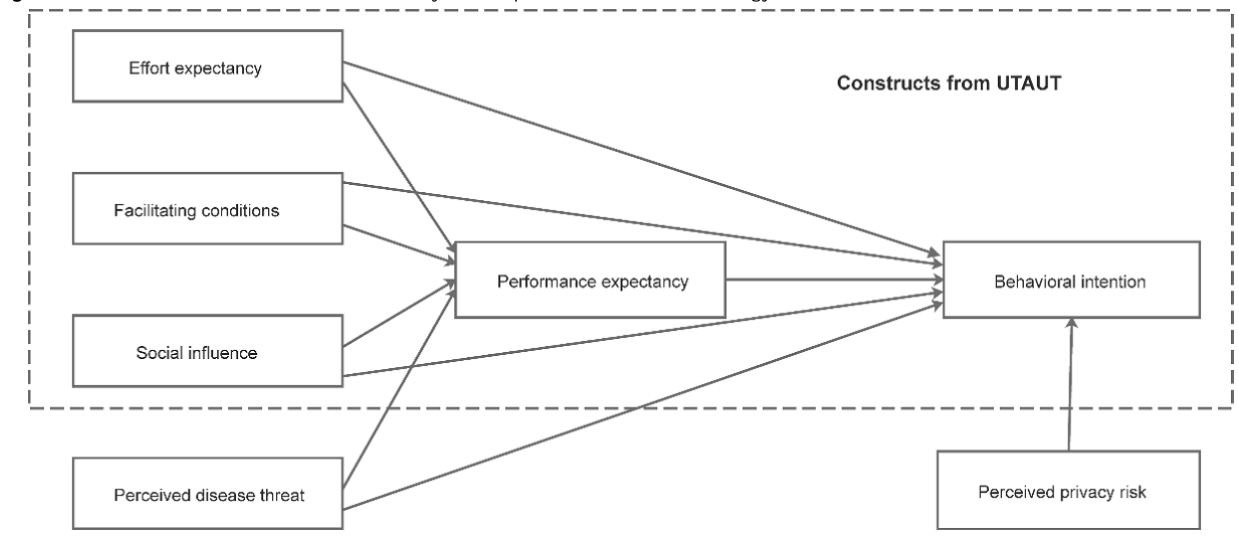
Figure 1. Research model. UTAUT: Unified Theory of Acceptance and Use of